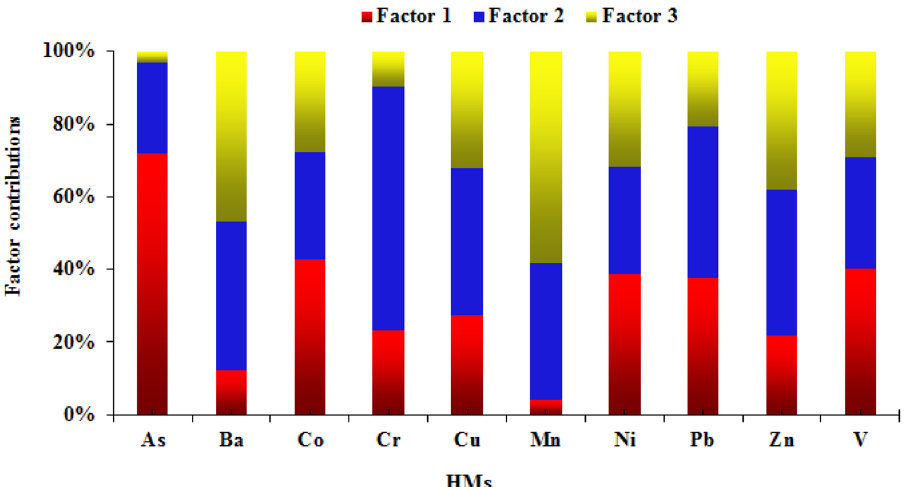
Figure 4. Source contribution rates of the three sources to HMs in the topsoil of